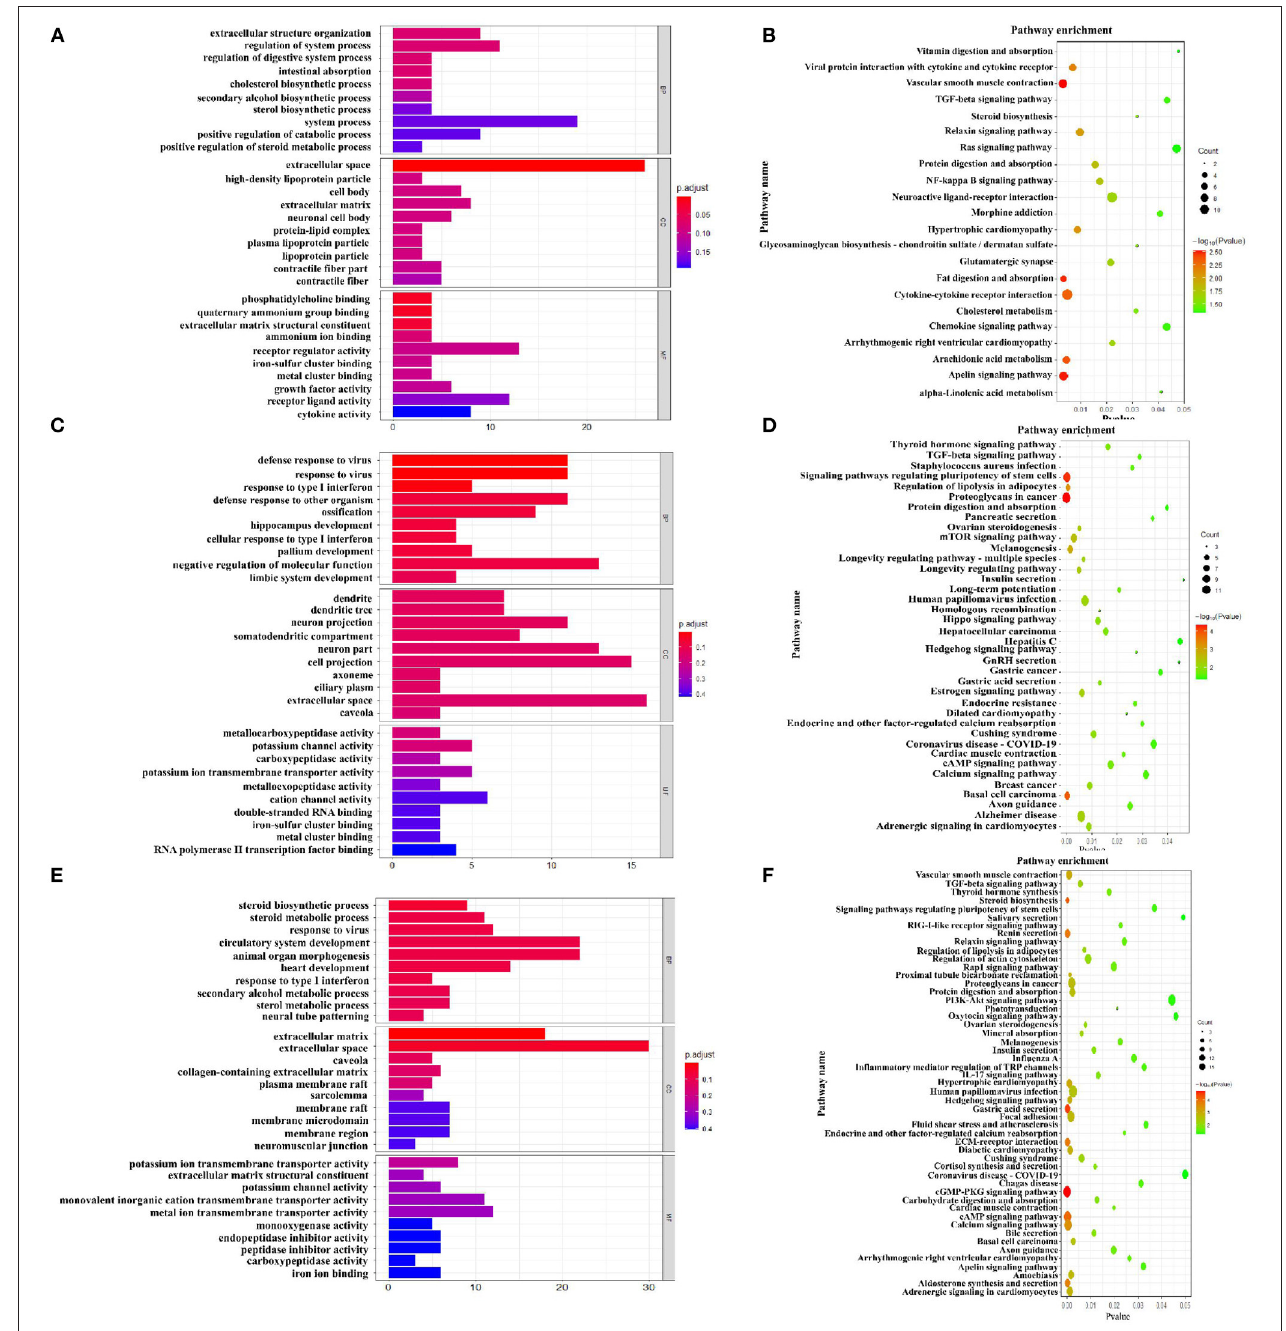
FIGURE 7 | Function analysis of different expression genes (DEGs) in colon mucosa between two treatment groups based on Gene Ontology and KEGG pathway. (A) Enriched GO terms of DEGs between M3 and M1 groups; (B) KEGG enrichment analysis of DEGs between M3 and M1 groups; (C) Enriched GO terms of DEGs between M5 and M1 groups; (D) KEGG enrichment analysis of DEGs between M5 and M1 groups; (E) Enriched GO terms of DEGs between M5 and M3 groups; (F) KEGG enrichment analysis of DEGs between M5 and M3 groups. M1, one meal per day; M3, three meals per day; M5, five meals per day.